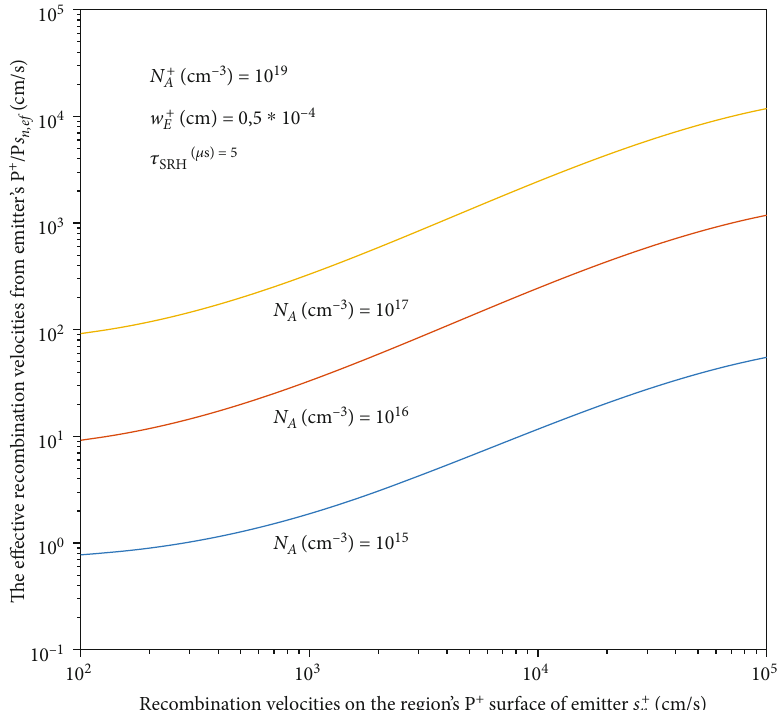
Figure 12: The e ff ective recombination velocities from the emitter ’ s interface P + /P s region ’ s P + surface of emitter s n + in the following conditions: N A + = 10 19 cm − 3 , w E + = 0 : 5 × 10 − 4 cm , and τ